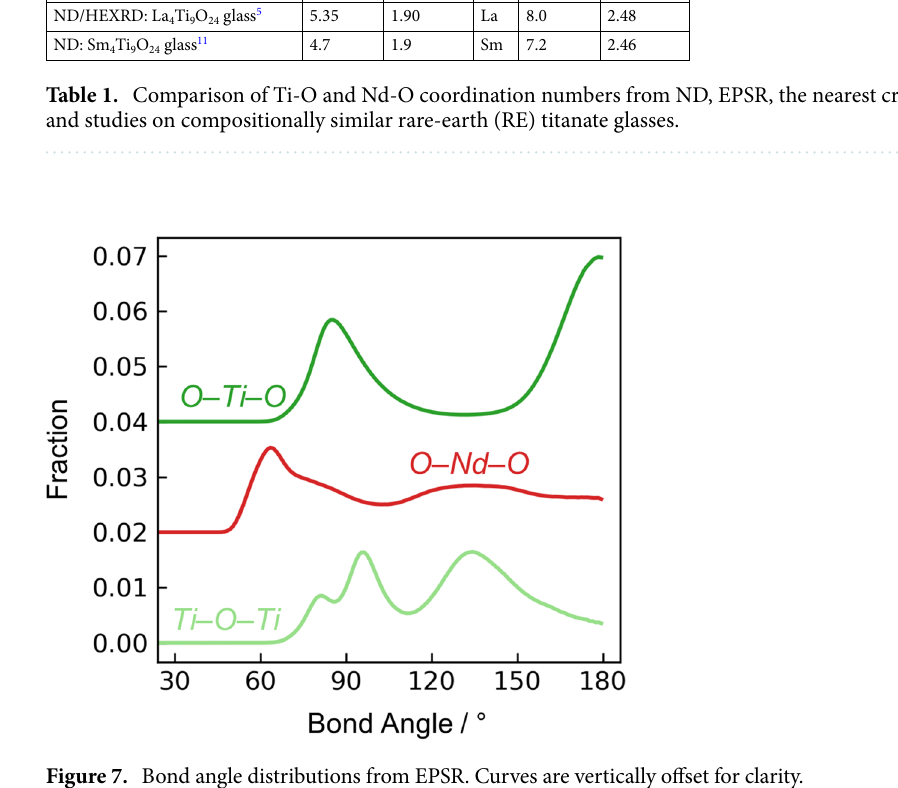
Figure 7. Bond angle distributions from EPSR. Curves are vertically offset for